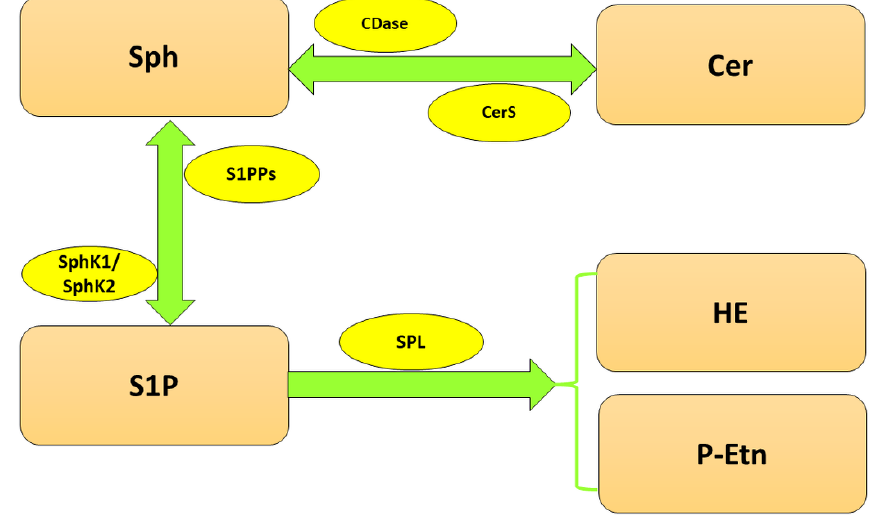
Figure 1. Metabolism of sphingolipids. Abbreviations: CDase—ceramidase; Cer—ceramide; CerS—ceramide synthase; HE—hexadecenal; P-Etn—phosphoethanolamine; Sph—sphingosine; SphK1—sphingosine kinase 1; SphK2—sphingosine kinase 2; S1P—sphingosine-1-phosphate; SPL—sphingosine-1-phosphate lyase; S1PPs—sphingosine-1-phosphate phosphatases.